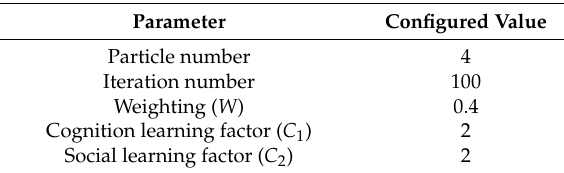
Table 2. Parameter configuration of the conventional PSO.